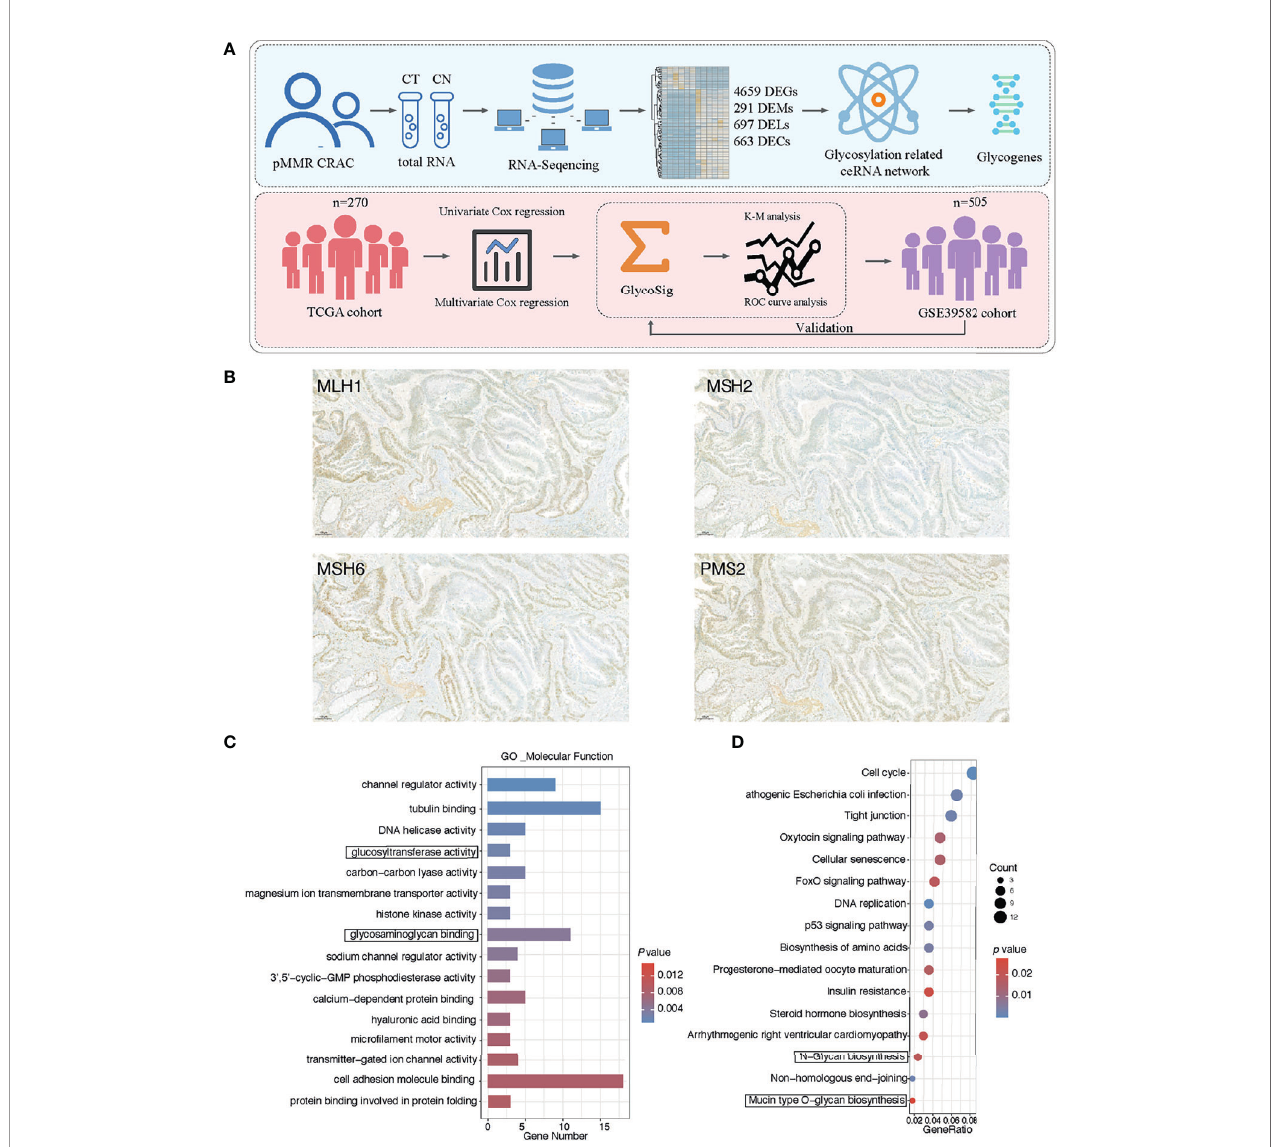
FIGURE 1 | Cancer-speci fi c messenger RNAs (mRNAs) in pro fi cient mismatch repair (pMMR) colorectal adenocarcinoma (CRAC) and functional enrichment analysis. (A) Work fl ow of the experiment process. (B) The representative pattern of mismatch repair (MMR) status for CRAC tissues. (C) Top 16 enriched Gene Ontology (GO) terms of molecular function; y axis represents GO terms, and x axis represents gene number. Color of the bars represent enrichment signi fi cance. (D) Top 16 enriched Kyoto Encyclopedia of Genes and Genomes (KEGG) pathways; y axis represents pathway names, and x axis represents rich factor. Size and color of the bubble represent number of differentially expressed mRNAs (DEGs) enriched in the pathway and enrichment signi fi cance,